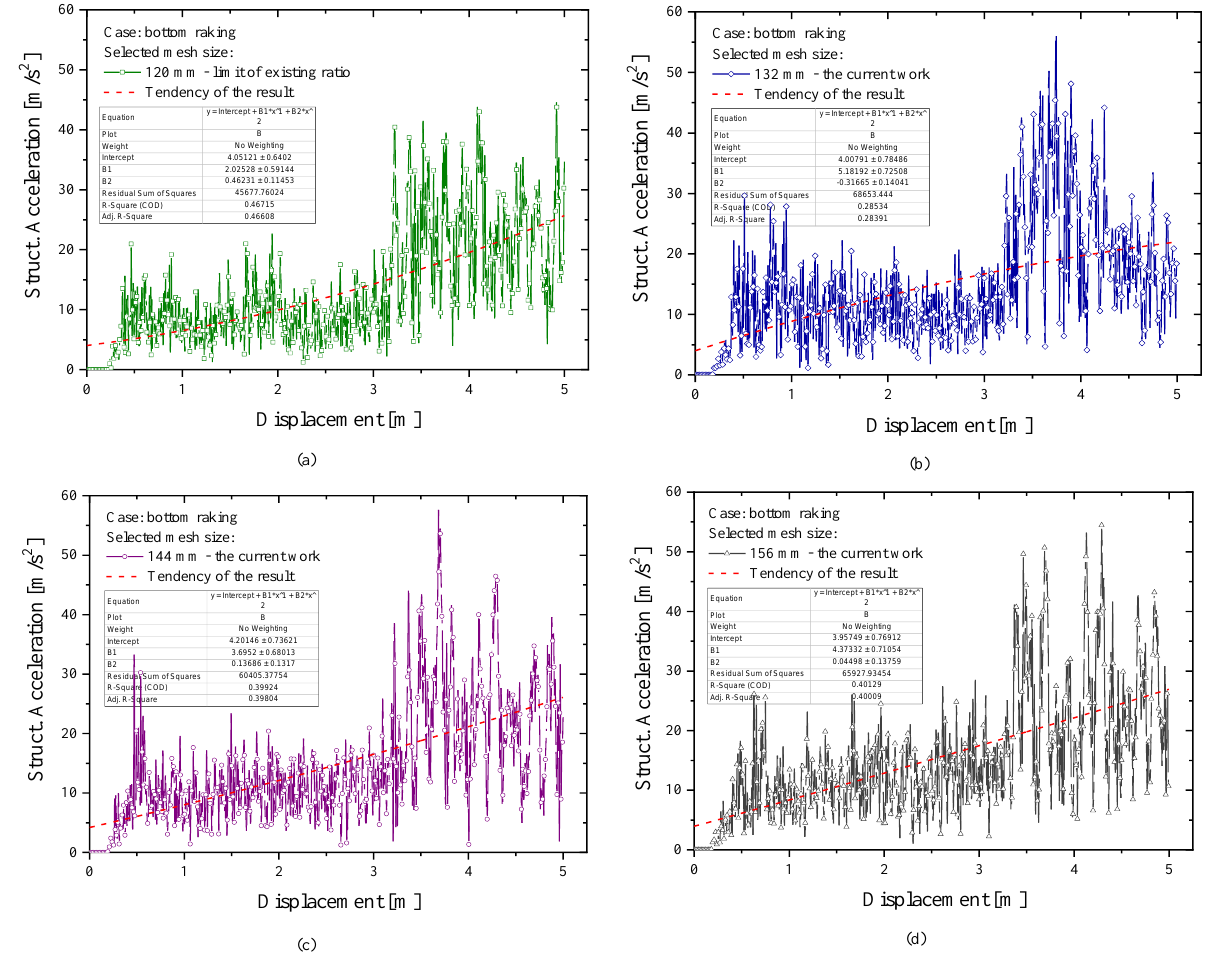
Figure 15. Acceleration of the double bottom: (a) 120 mm, (b) 132 mm, (c) 144 mm and (d) 156 mm.